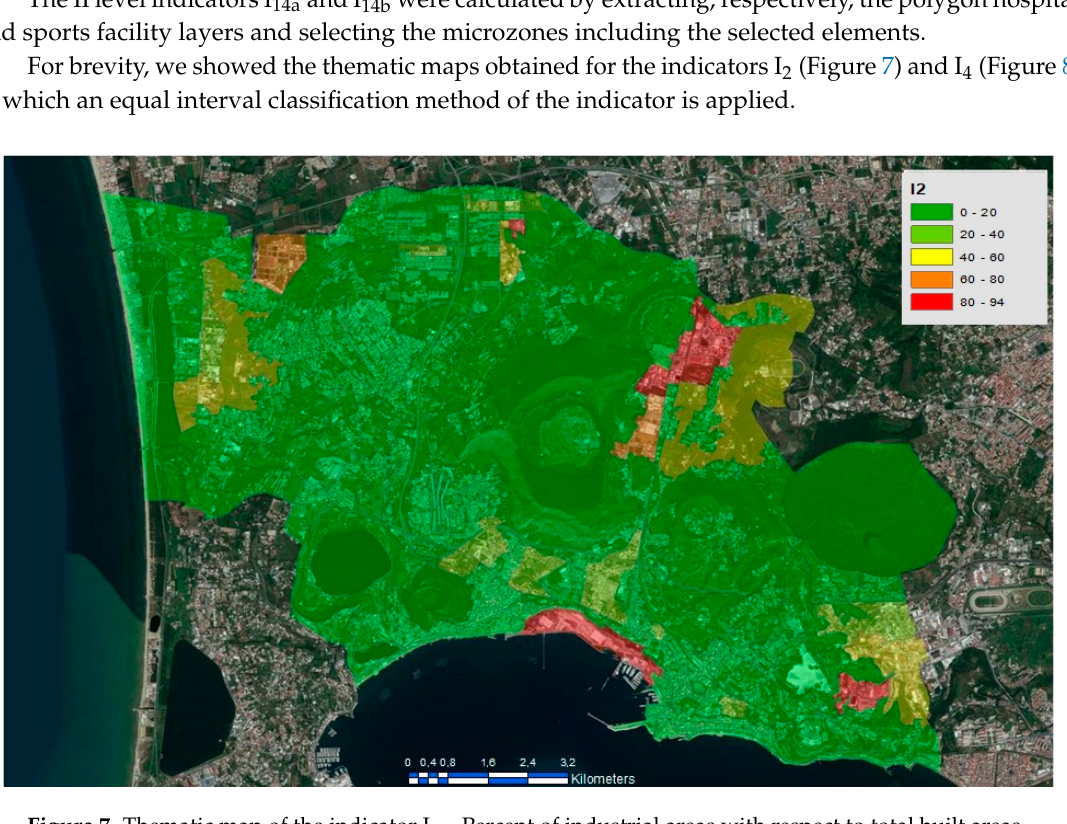
Figure 8. Thematic map of the indicator I 4 —Percent of green areas with respect to the area of the microzone. After calculating the crisp values of the indicators, we applied the fuzzification process, executing the fuzzifier component of the fuzzy rule system.